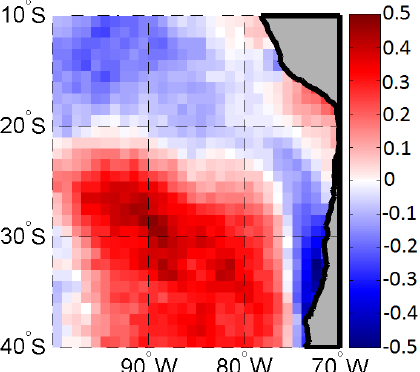
Fig. 8. Fractional composite difference of albedo on the dominant principal component of SLP during a season: September-October- November, 2000–2008. Compare with Fig. 7a.